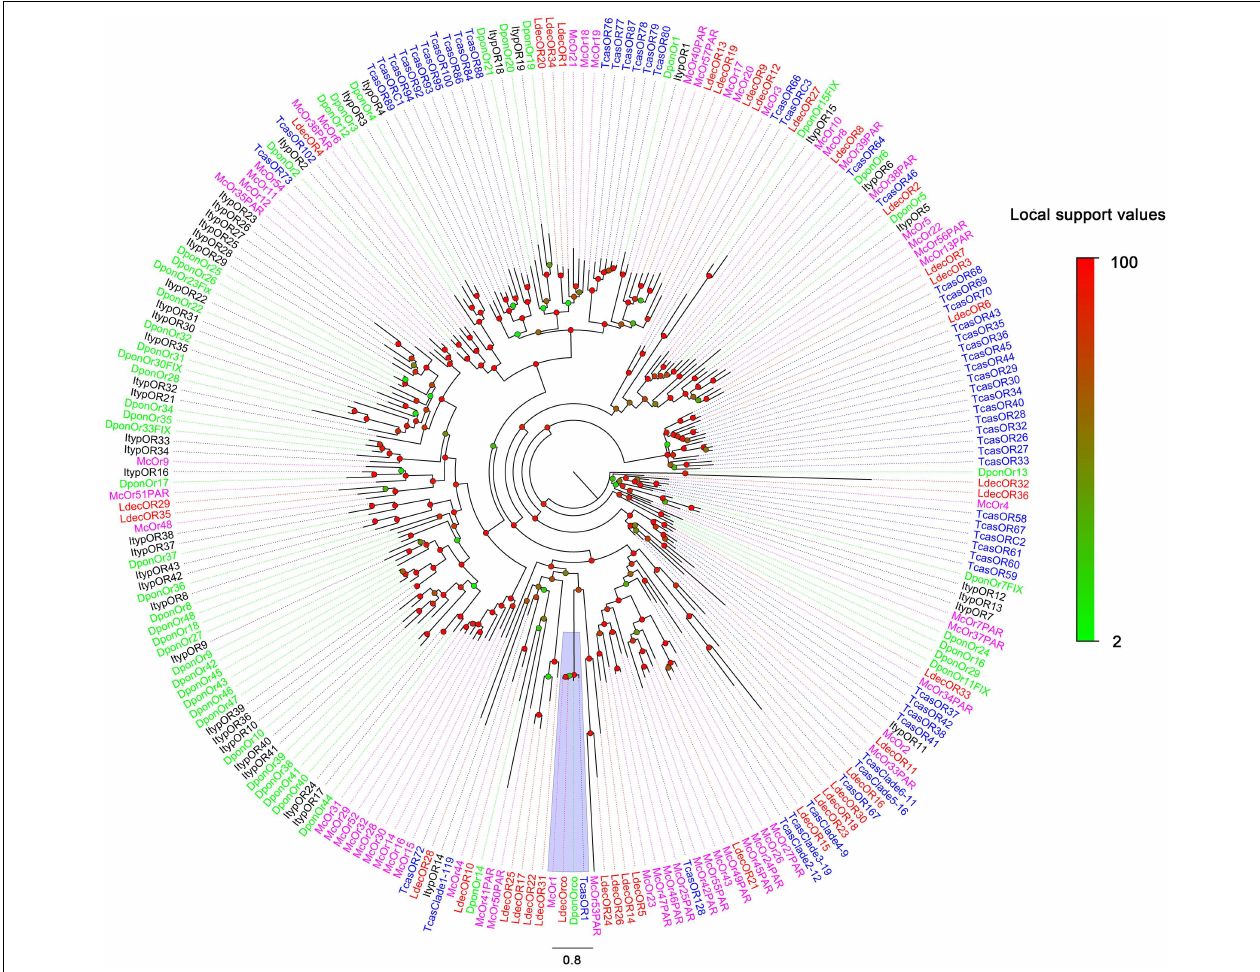
FIGURE 5 | Phylogenetic tree of candidate LdecORs with known Coleopteran OR sequences. Tcas, T. castaneum ; Dpon, D. ponderosae ; Ityp, I. typographus ; Ma, M. caryae. The clade in purple indicates the co-receptor gene clade.